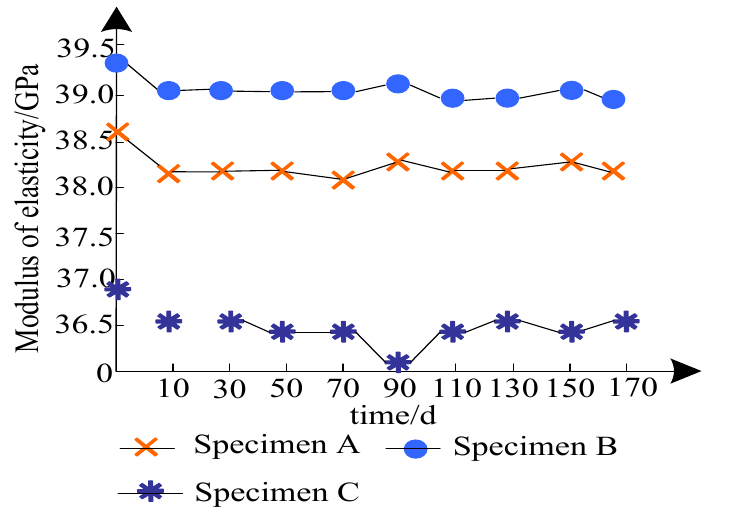
Figure 5. Stress–straincurve of bolt specimen.